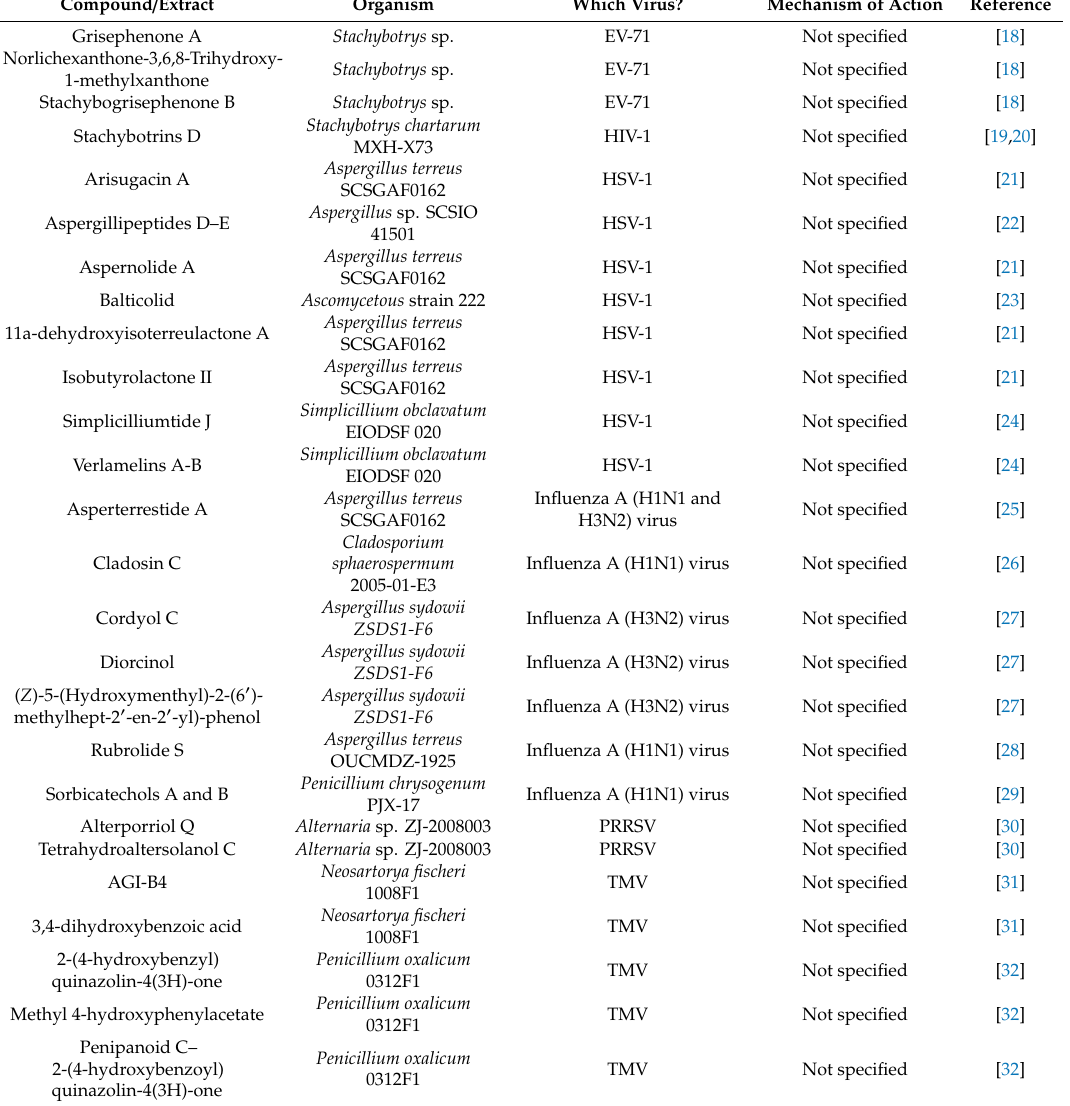
Table 2. The table report antiviral compounds / extracts from marine fungi. EV-71, Enterovirus 71; HIV, Human Immunodeficiency virus; HSV-1, Herpes Simplex virus 1; PRRSV, Porcine Reproductive and Respiratory virus; TMV, Tobacco Mosaic